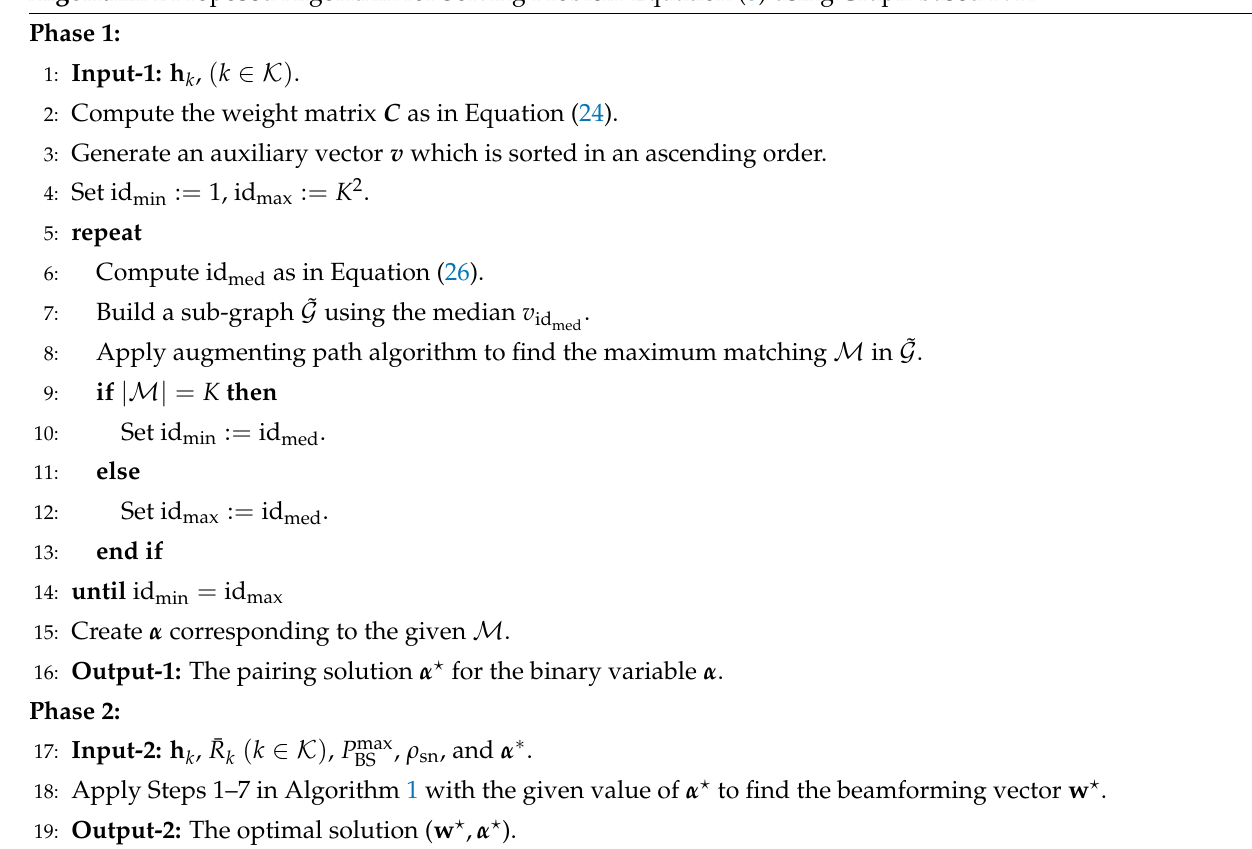
Algorithm 2 Proposed Algorithm for Solving Problem Equation (8) using Graph-based IVR. Phase